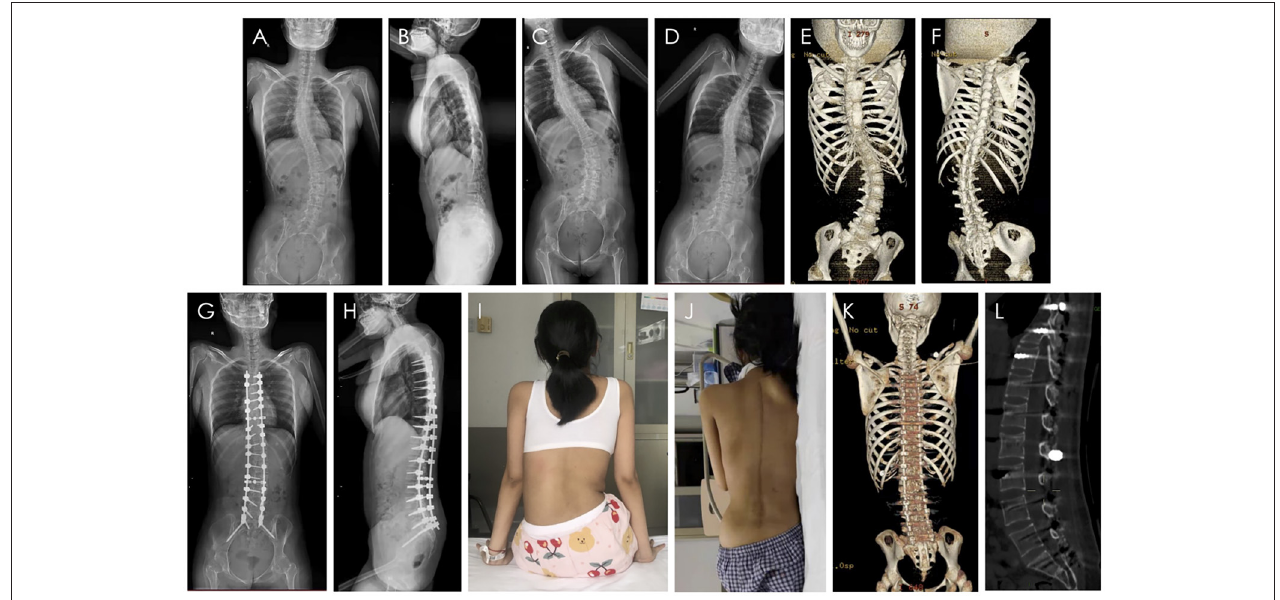
FIGURE 1 | Scoliosis orthopedic surgery. X-ray, CT images and appearance of the SMA patient with scoliosis. (A) The anteroposterior view of spinal X-ray before surgery. (B) The lateral view of spinal X-ray before surgery. (C,D) The left and right bending view of spinal X-ray before surgery. (E,F) The three-dimensional CT images before surgery. (G) The anteroposterior view of spinal X-ray after surgery. (H) The lateral view of spinal X-ray after surgery. (I) The appearance of the back before surgery. (J) The appearance of the back after surgery. (K) The three-dimensional CT images after surgery. (L) The sagittal CT images after surgery and the osseous channel are circled in the